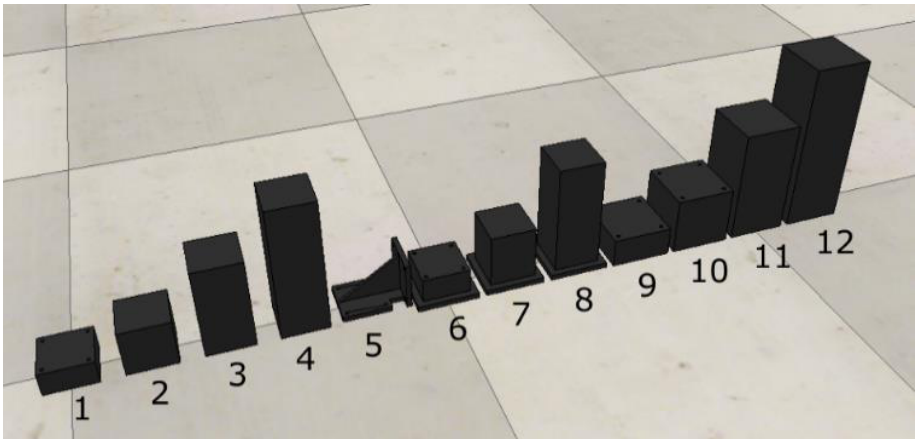
Figure 4. ID numbers for the basic manipulator